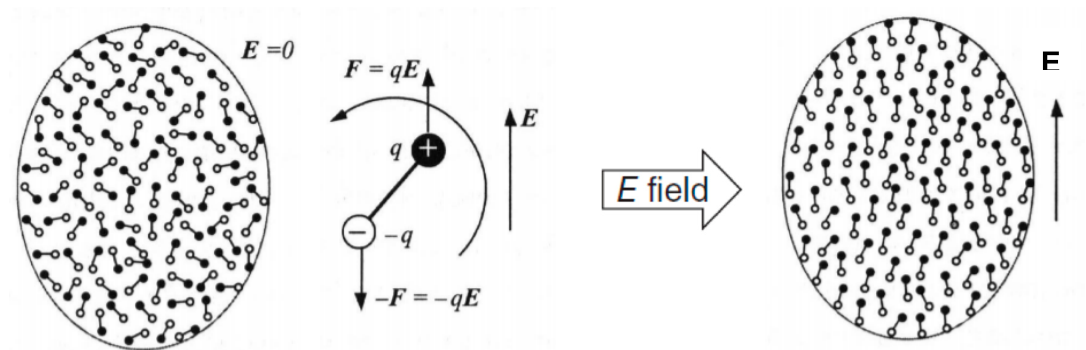
Figure 2. The effect of an electric field E on the dipoles of a polar molecule. Figure 2. The e ff ect of an electric field E on the dipoles of a polar